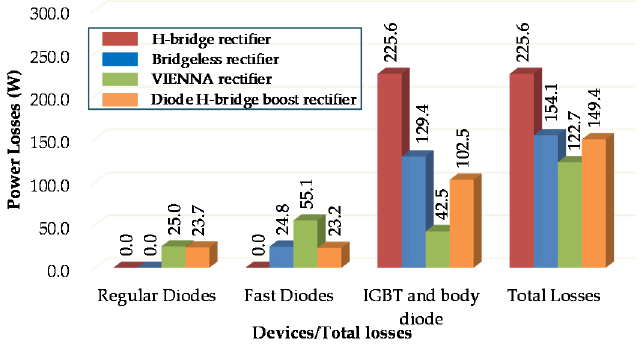
Figure 8. Loss distribution of the semiconductors.